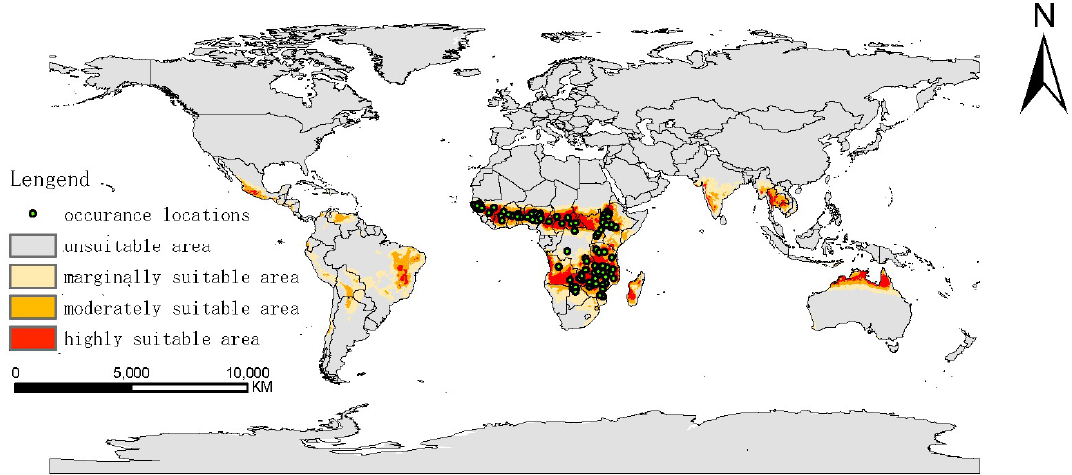
Figure 4. Occurrence locations of Glossina morsitans and potentially suitable area under historical situation. (probability: unsuitable area 0–0.097; marginally suitable are 0.097–0.323; moderately suitable area 0.323–0.603; highly suitable area 0.603–1).